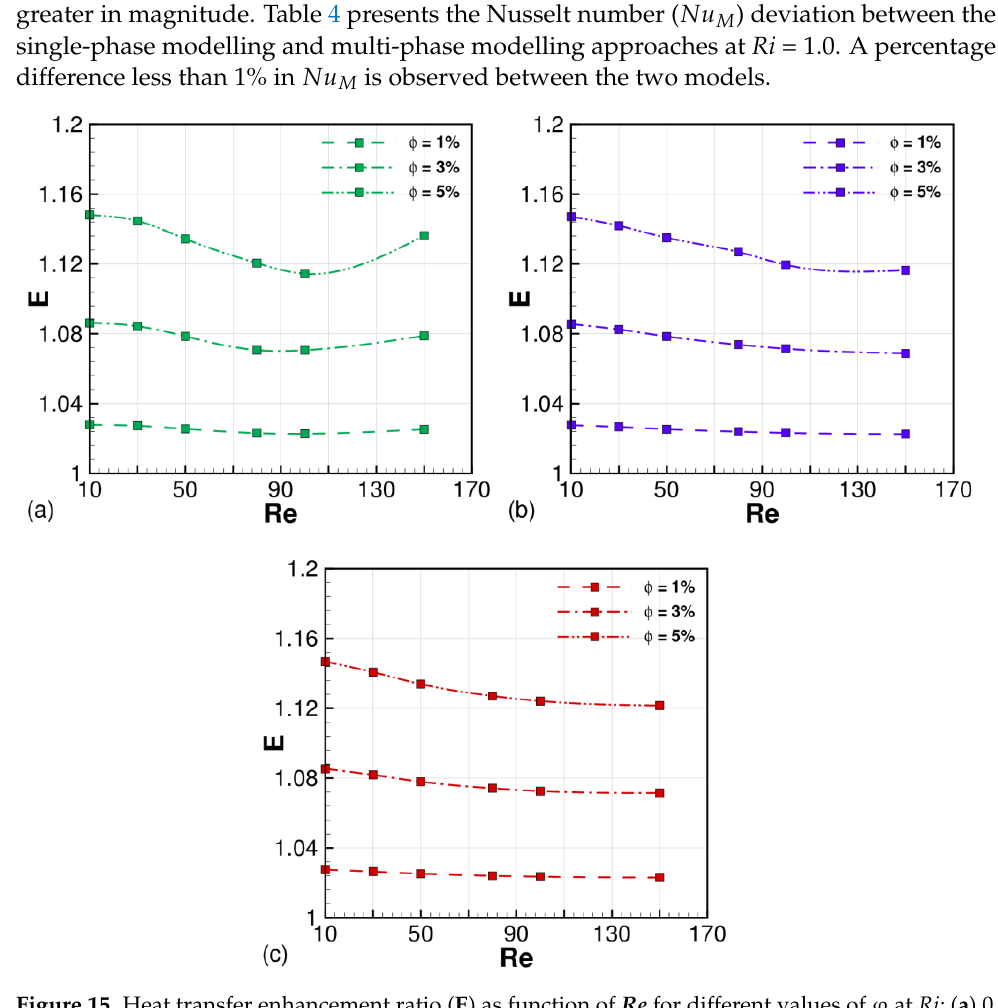
Figure 15. Heat transfer enhancement ratio (E) as function of Re for different values of φ at Ri ; ( a ) 0, ( b ) 0.5, and ( c ) 1. ( b ) 0.5, and ( c )